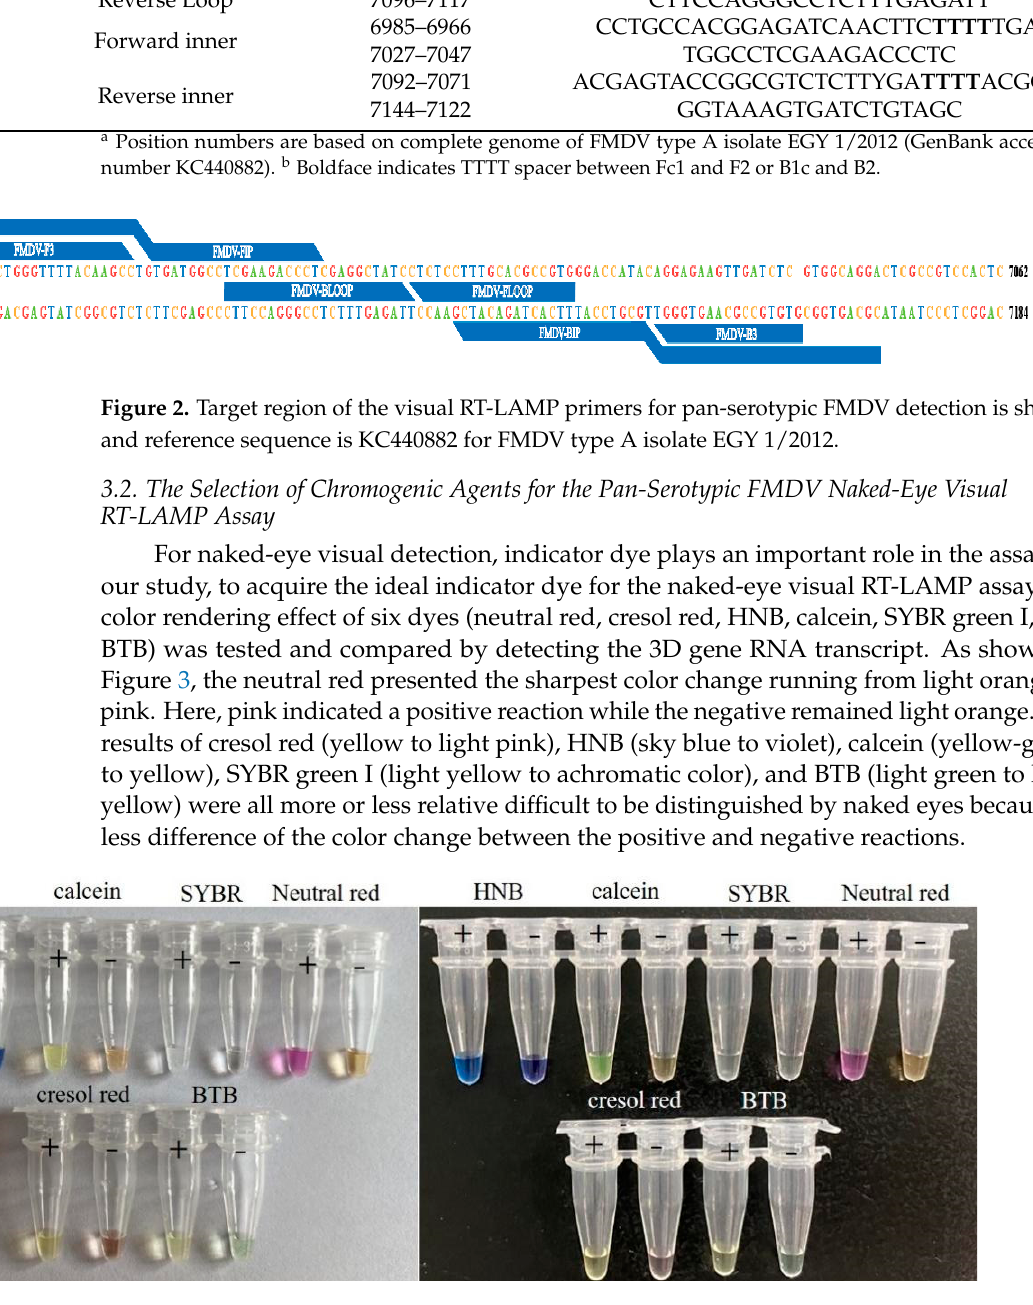
Figure 3. The selection of the indicator dye for the naked-eye visual RT-LAMP assay. The comparison of the color change between the positive and negative reactions of the assay with six different indicator dyes including HNB, calcein, SYBR green I, neutral red, cresol red, and BTB. The results were presented in both white and black backgrounds with positive and negative reactions. Positive reactions were shown by “+” and negative reactions were shown by “ − ”.